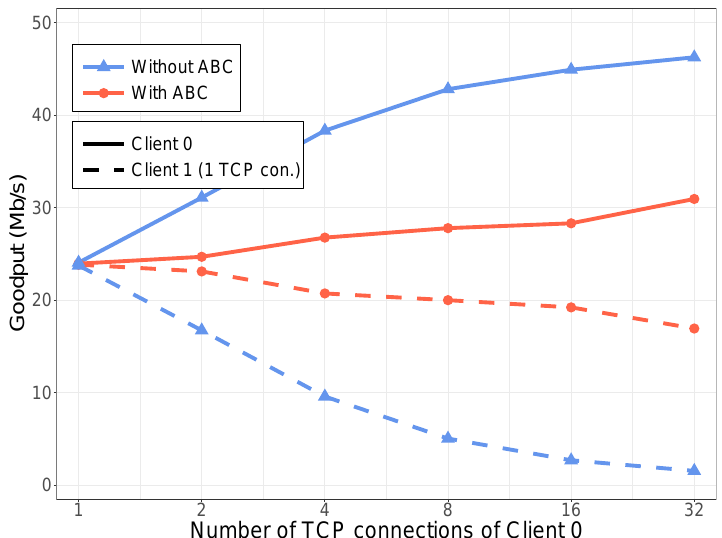
Figure 5. Resource sharing with TCP traffic; the number of saturated TCP connections of Client 0 is indicated on the x -axis while Client 1 has only one saturated TCP